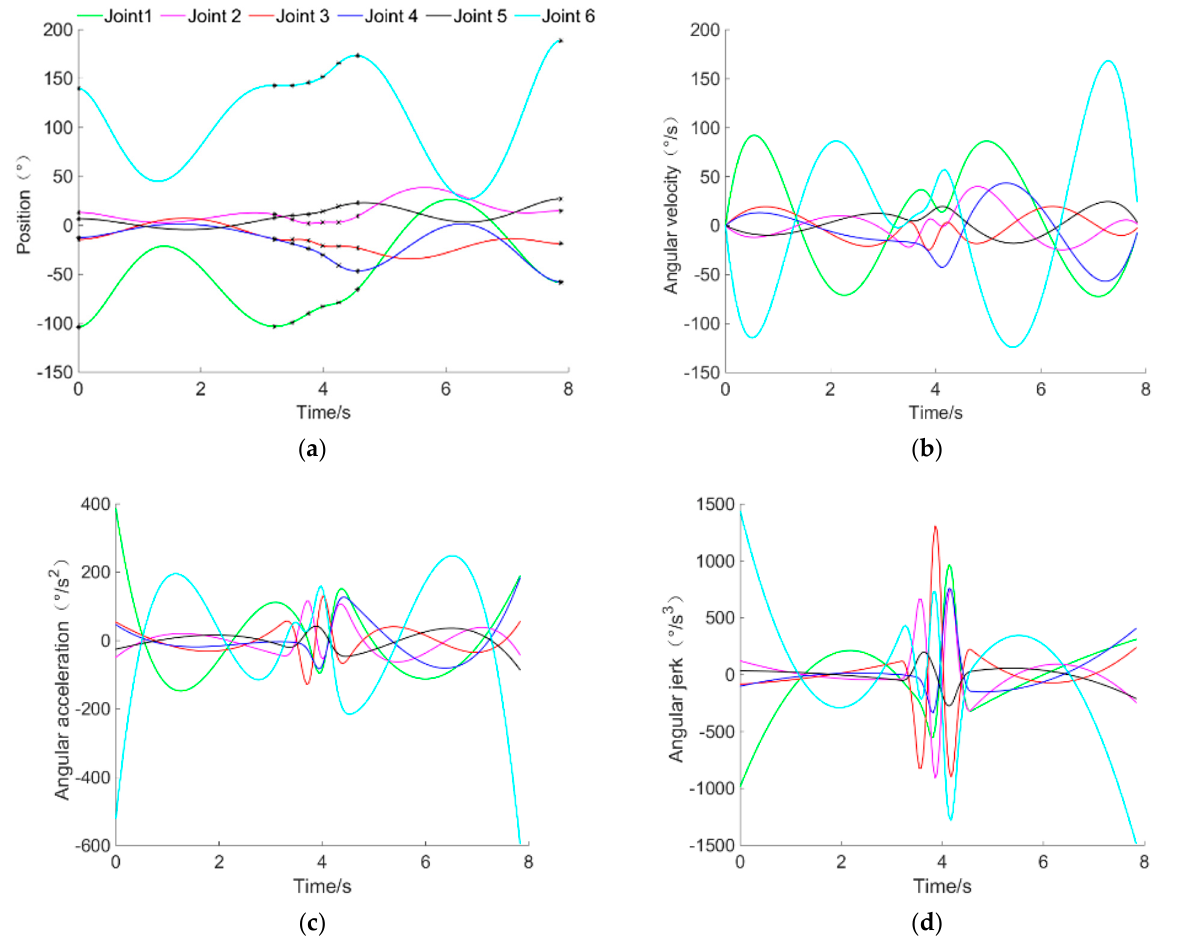
Figure 7. Time optimal trajectory; ( a ) Position − Time chart of each joint; ( b ) Speed − Time chart of each joint speed; ( c ) Acceleration − time chart of each joint; ( d ) Jerk − time chart of each joint.